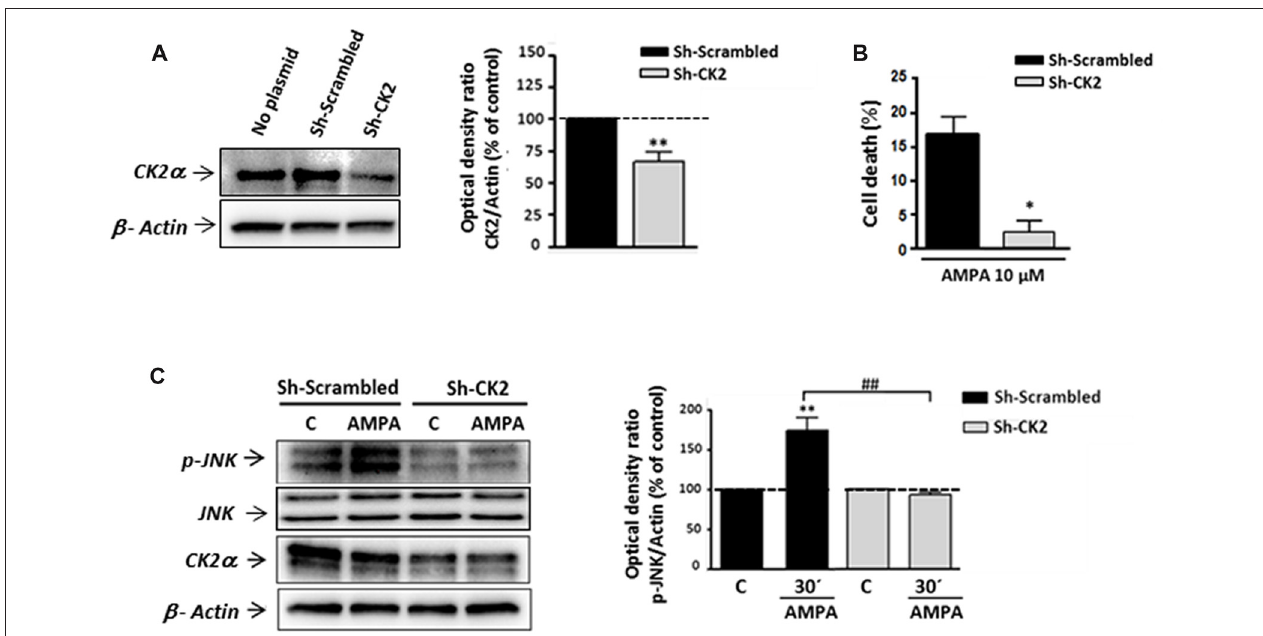
FIGURE 5 | Gene silencing of CK2 mimics its pharmacological inhibition with pro-survival effects on oligodendrocytes exposed to AMPA. Isolated oligodendrocytes from mixed glial cultures were immediately transfected with Sh-Scrambled or Sh-CK2 (as described in “Materials and Methods” section) and then were maintained in culture until used. (A) WB analysis of endogenous CK2 α expression in lysates of non-transfected cells (no plasmid) and cells transfected with shRNAs directed at CK2 (Sh-CK2) or the control sequence (Sh-Scrambled). Sh-CK2 reduced the expression of CK2 compared with non-transfected cells or transfected with control shRNA. The analysis of the β -actin was performed as an internal load control. ∗∗ p < 0.01 (vs. Sh-Scrambled transfected cells). (B) Transfected oligodendrocytes were exposed to usual excitotoxic conditions (10 µ M CTZ for 30 min), and cell viability was assayed 24 h later using calcein-AM. Knocking down-CK2 cells are less vulnerable to AMPA-induced cell death than Sh-Scrambled transfected cells. ∗ p < 0.05 (vs. Sh-Scrambled transfected cells treated with agonist). (C) WB analysis of JNK phosphorylation state in transfected oligodendrocytes after excitotoxic insults. Cells were transfected with Sh-Scrambled or Sh-CK2, maintained in control situation or treated with AMPA (10 µ M, 30 min) and subjected to western blotting with specific antibodies against phospho-JNK, total JNK, CK2 α and β -actin, 30 min post-stimulus. Quantification shows that JNK phosphorylation by AMPA exposure was significantly blocked in Sh-CK2 transfected cells as compared to Sh-Scrambled transfected cells, without changing expression levels of total JNK. Detection of CK2 α in these samples corroborated that expression of kinase was notably reduced in Sh-CK2 transfected oligodendrocytes. Analysis of β -actin was performed as an internal load control. ∗∗ p < 0.01 (vs. control situation without AMPA treatment); ## p < 0.01 (vs. Sh-Scrambled transfected cells treated with